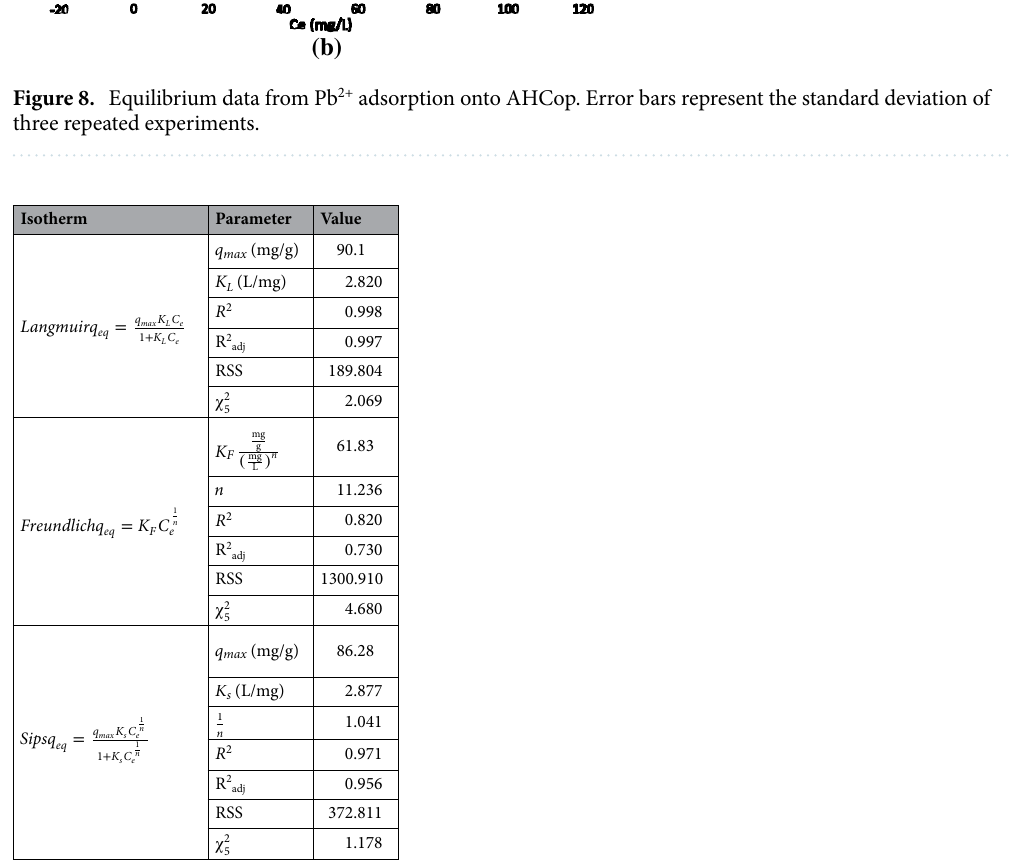
Table 7. Isotherm parameters of Pb 2+ adsorption on the AHC op (T = 25 °C).